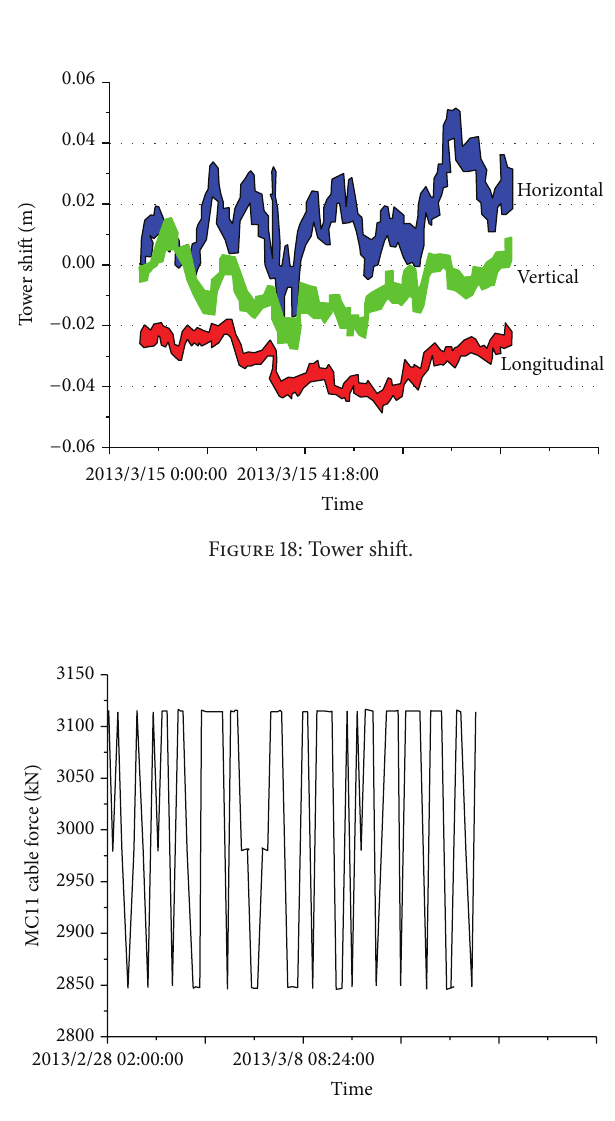
Figure 19: Cable